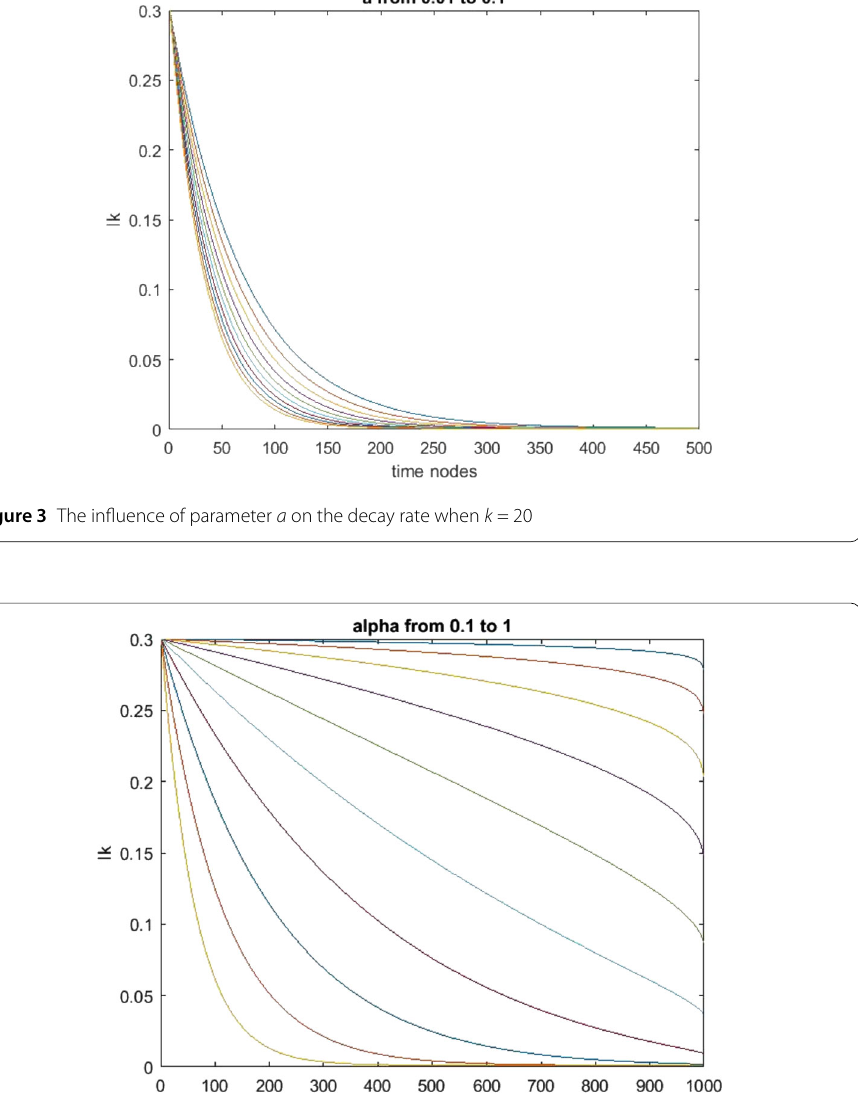
equilibrium point or an endemic equilibrium point, both states are stable and the disease will not spread to all individuals. Finally, numerical simulations were presented to demon- strate the effectiveness of the theoretical results and the influence of treatment function and fractional order to the spreading dynamics. Note that the linear treatment function is not suitable for some infectious disease, for example, cholera,flu, etc., because they have complex transmission characteristics and are affected by many factors. More effective con- trol methods will be developed and evaluated in our future studies. Besides, the feasibility of solving the fractional equations with other numerical methods, e.g., the methods pro- posed in Refs. [33, 34], shall also be an interesting issue to be investigated in our future